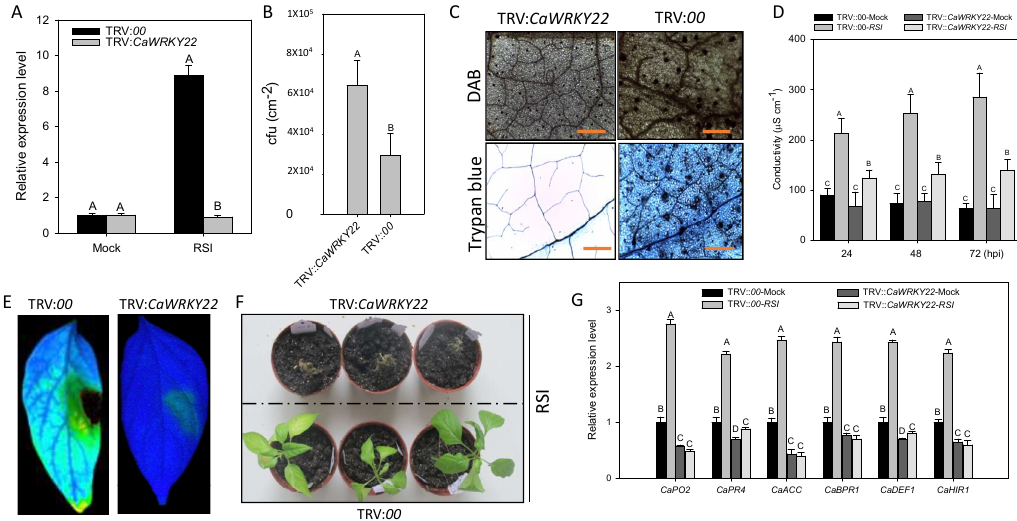
Figure 4. Distinctive responses of CaWRKY22- knockout attenuates the pepper’s resistance to RSI. ( A ) QRT-PCR analysis of CaWRKY22 expression in R. Solanacearum- inoculated, mock (inoculated with MgCl 2 solution) CaWRKY22- silenced pepper plants (TRV: CaWRKY22 ), and control plants (TRV:00); ( B ) difference in R. Solanacearum growth between CaWRKY22- silenced and control pepper plants inoculated with R. Solanacearum at 3 dpi (days post inoculation); ( C ) DAB and trypan blue staining in R. Solanacearum- inoculated CaWRKY22- silenced (TRV: CaWRKY22 ) and control (TRV:00) pepper leaves at 48 hpi. Scale bar = 50 µm; ( D ) electrolyte leakage as ion conductivity to assess the cell death responses in the leaf discs of CaWRKY22- silenced (TRV: CaWRKY22 ) and control (TRV:00) pepper after 24, 48, and 72 h of inoculation with and without R. Solanacearum ; ( E ) cell death in R. Solanacearum inoculated CaWRKY22- silenced (TRV: CaWRKY22 ) and control (TRV:00) pepper leaves under fluorescent modulation meter; ( F ) phenotypic effect of R. Solanacearum treatment on CaWRKY22- silenced (TRV: CaWRKY22 ) and control (TRV:00) pepper plants at 7 dpi; ( G ) qRT-PCR analysis of transcriptional levels of defense-related marker genes in CaWRKY22- silenced (TRV: CaWRKY22 ) and control (TRV:00) pepper plants 24 h post inoculation with R. Solanacearum . The relative expression level of mock treated unsilenced plants was set to “1”. Error bars indicated the standard error. Data represents the means ± SD from four biological replicates. Different letters indicate significant differences, as determined by Fisher’s protected LSD test: uppercase letters, p < 0.01; lower case letters, p <